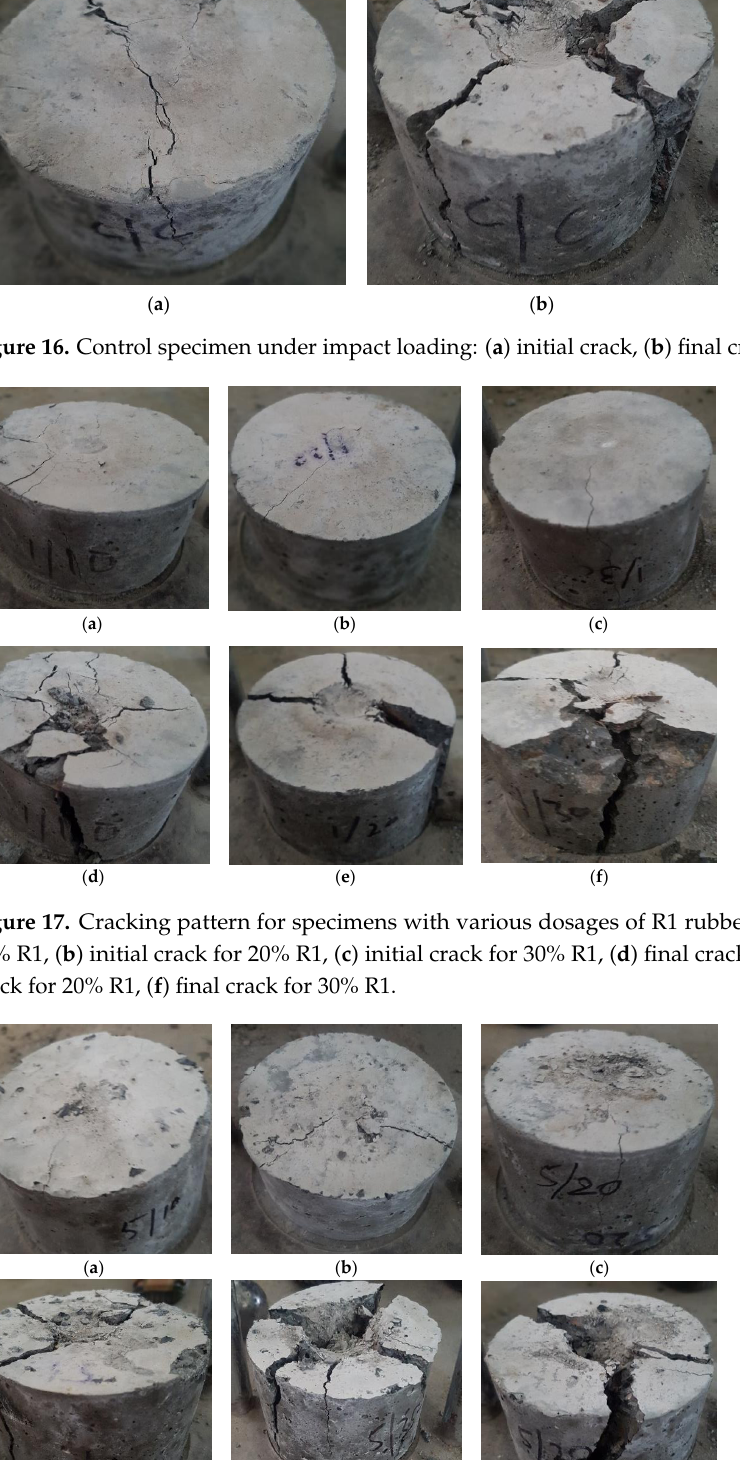
Figure 18. Cracking pattern for specimens with various dosages of R5 rubber: ( a ) initial crack for 10% R5, ( b ) initial crack for 20% R5, ( c ) initial crack for 30% R5, ( d ) final crack for 10% R5, ( e ) final crack for 20% R5, ( f ) final crack for 30% R5.